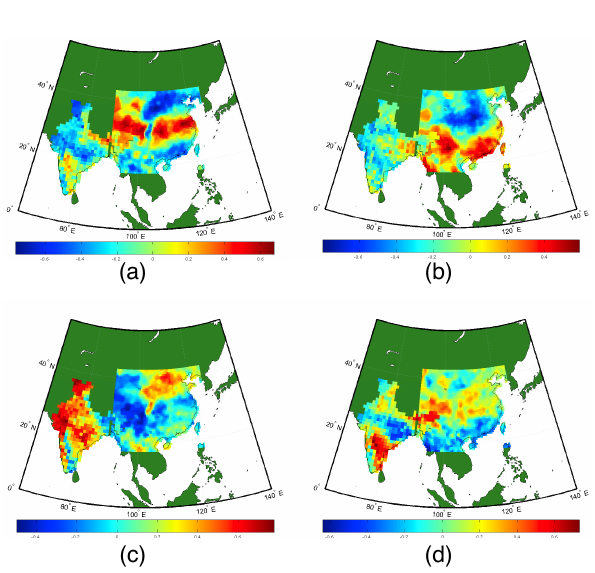
Fig. 2. Correlation maps between rainfall PCs and rainfall field of China and India. (a) China PC1 vs. rainfall field of China and India; (b) China PC2 vs. rainfall field of China and India; (c) India PC1 vs. rainfall field of China and India; (d) India PC2 vs. rainfall field of China and